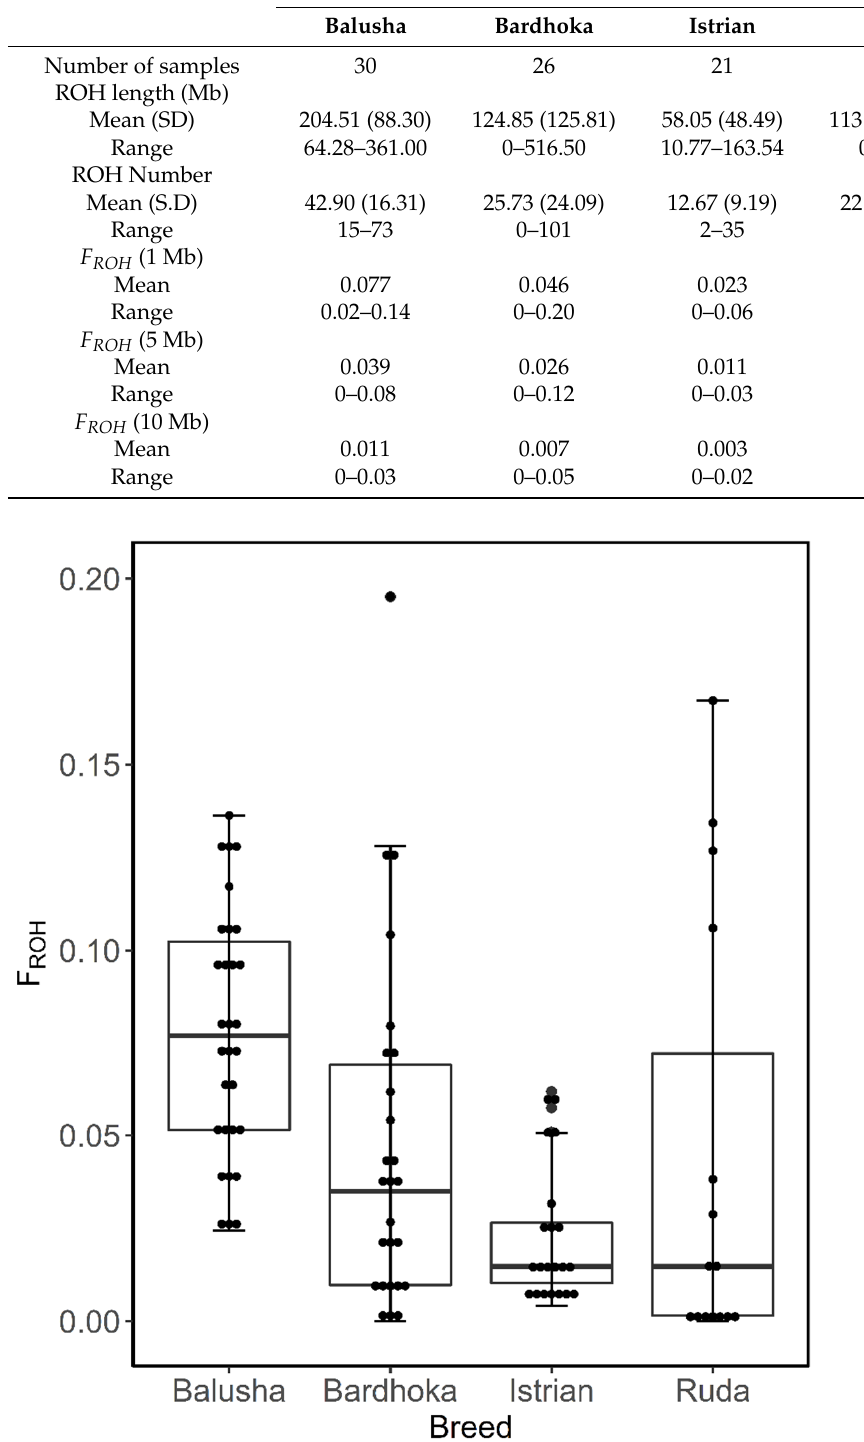
Figure 5. Box plots of within-breed distribution of runs of homozygosity inbreeding coefficient for each sheep breed.